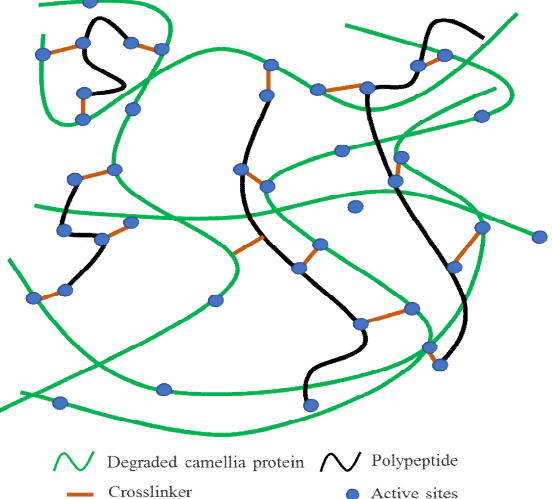
Figure 10. Schematic diagram of peptide chain reinforced Camellia oleifera cake-protein